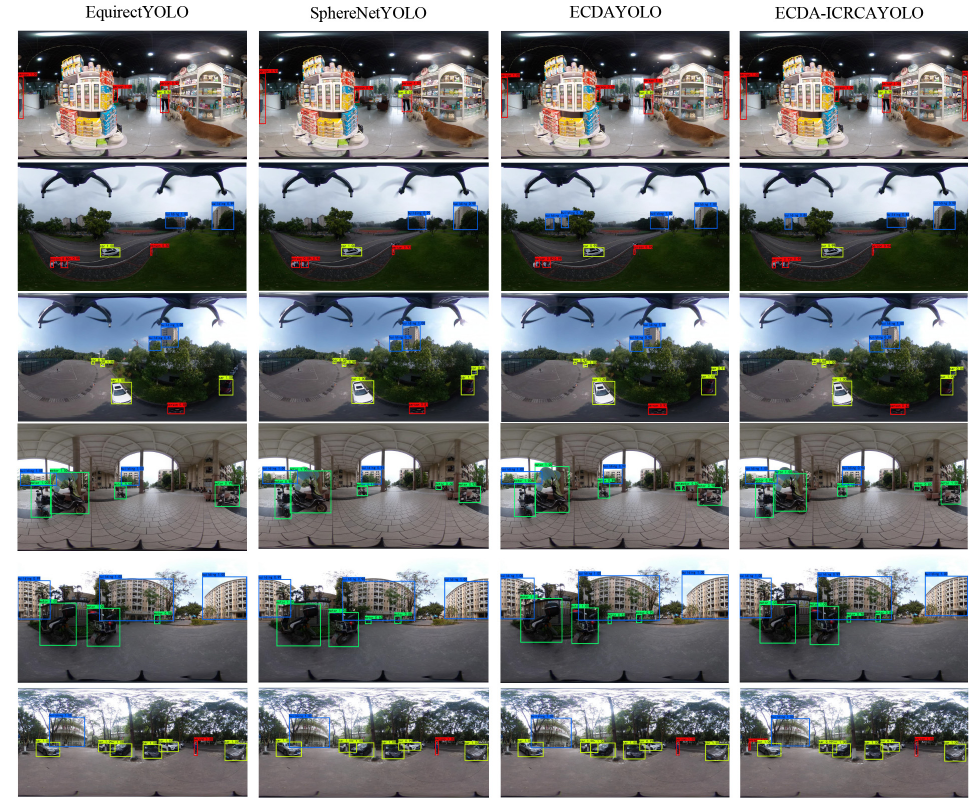
Figure 10. Object detection